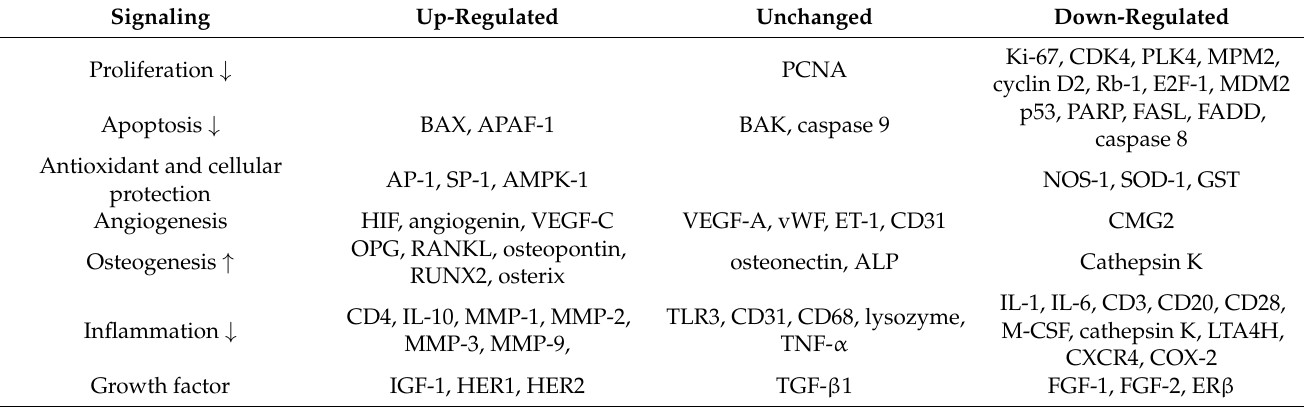
Table 2. Representative cellular signaling affected by Pentoxifylline in RAW 264.7